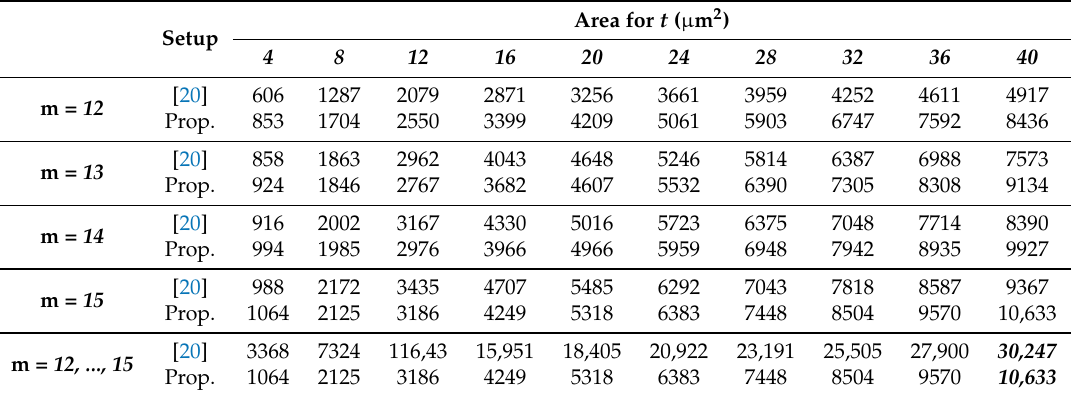
Table 2. Area comparison for different syndrome generators vs. the proposed SRU.